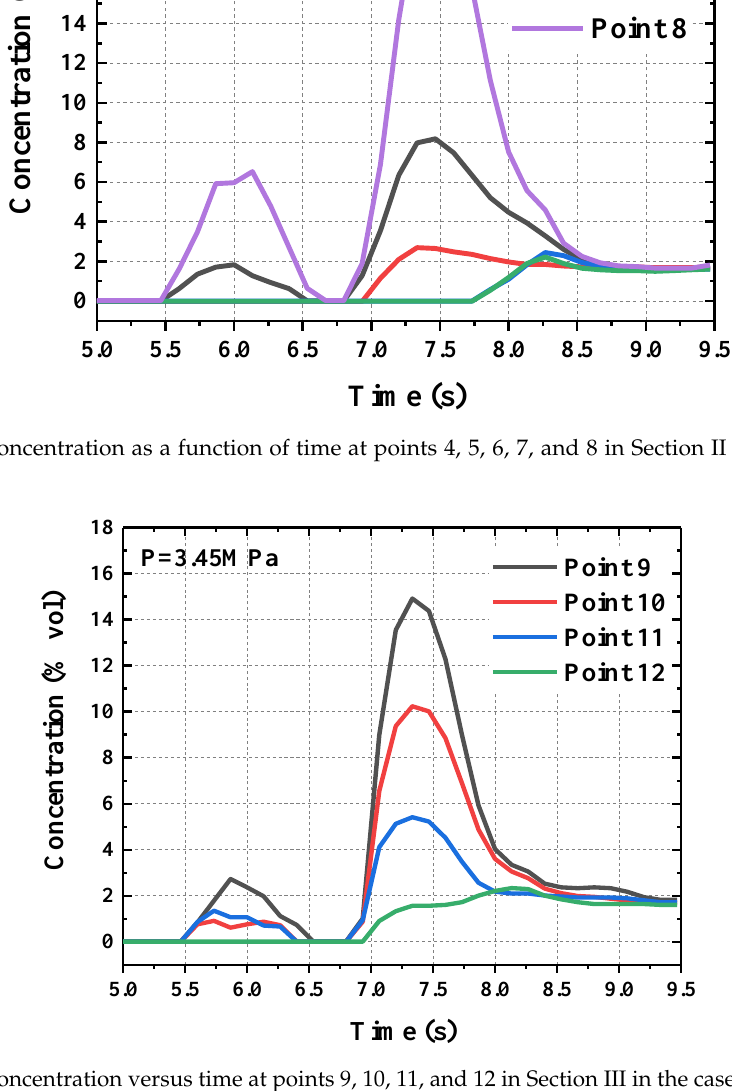
Figure 13. Concentration as a function of time at points 4, 5, 6, 7, and 8 in Section II in the case of 3.45 MPa.